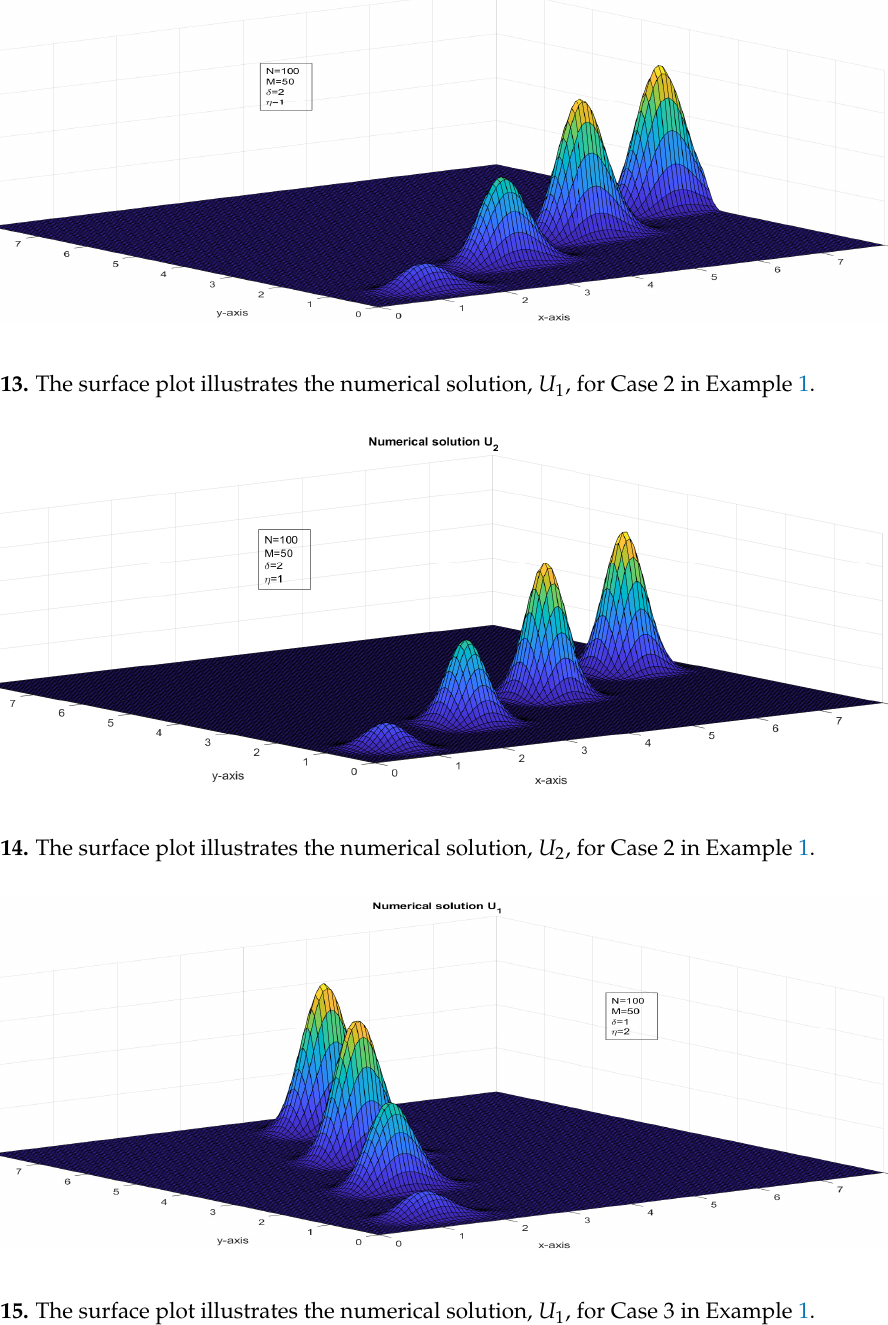
Figure 15. The surface plot illustrates the numerical solution, U 1 , for Case 3 in Example